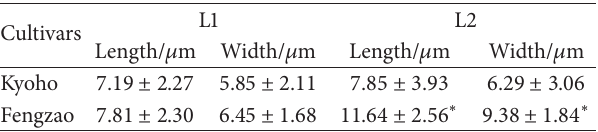
Table 3: Size of stem apex cell between experimental varieties. Cultivars